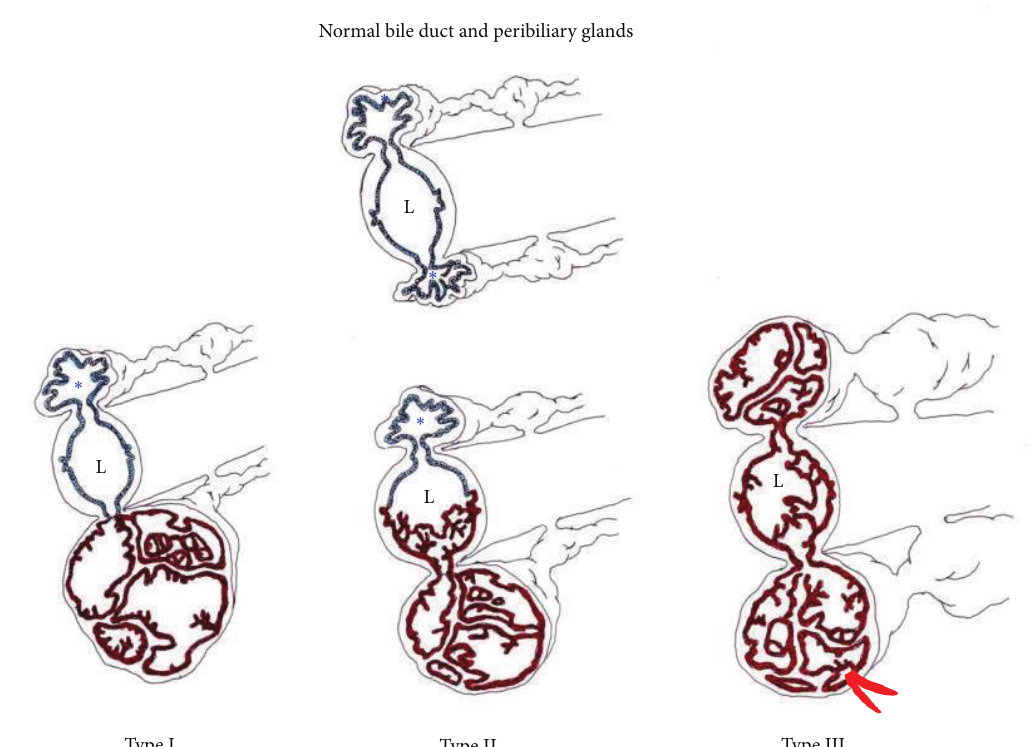
Figure 3: A schematic diagram of cystic and papillary neoplasms involving the peribiliary glands (PGs). The blue epithelium indicates nonneoplastic glands, and brown epithelium indicates neoplastic glands. Red indicates an invasion of carcinoma arising in the neoplasm of the PGs. L: bile duct lumen; ∗ unaffected PGs. Type I shows neoplastic involvement confined to the PG, and type II shows main involvement of the PGs with partial secondary involvement of the adjacent bile duct. Type III reflects extensive involvement of the PGs with simultaneous involvement of the bile ducts, which may appear grossly as peribiliary cysts in the perihilar